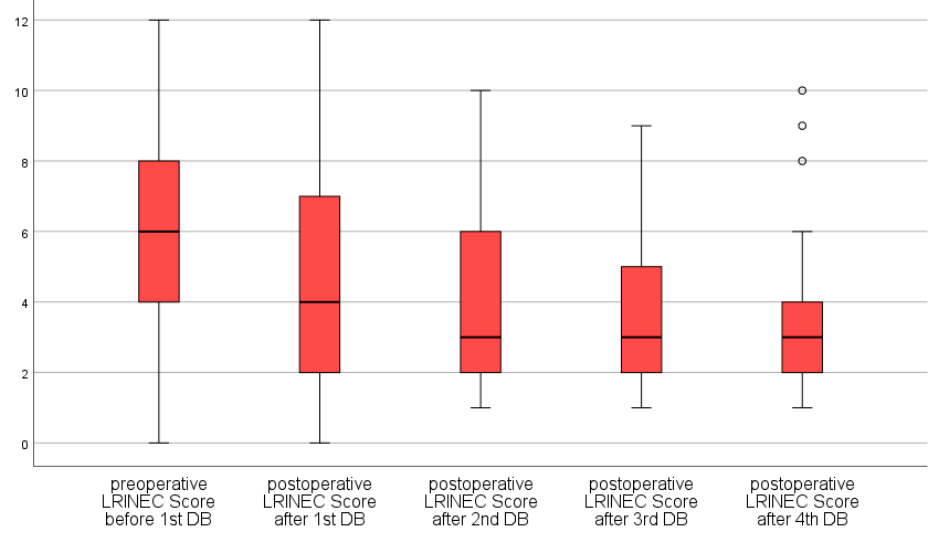
Figure 1. LRINEC in the course of time as a boxplot diagram.